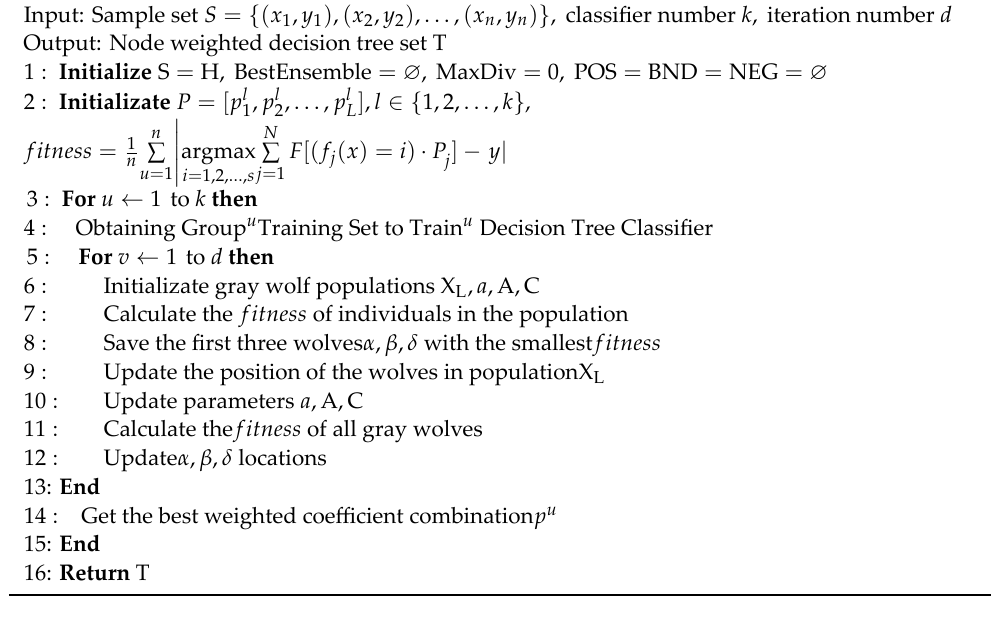
Algorithm 3: Random forest node weighting algorithm based on GWO